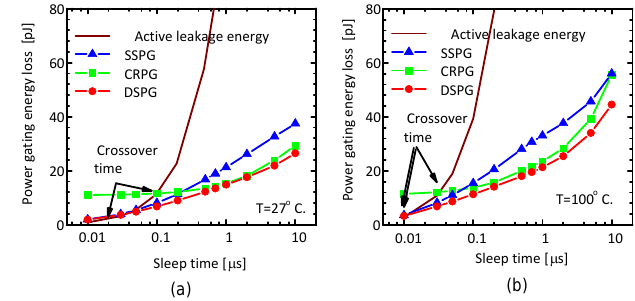
Figure 4. (a) Power gating energy loss comparison of the SSPG, CRPG, and DSPG with varying a sleep time at 27 o C using the 45-nm PTM, V W /W =10% (b) Energy loss comparison of the PG Logic SSPG, CRPG, and DSPG at 100 o C.